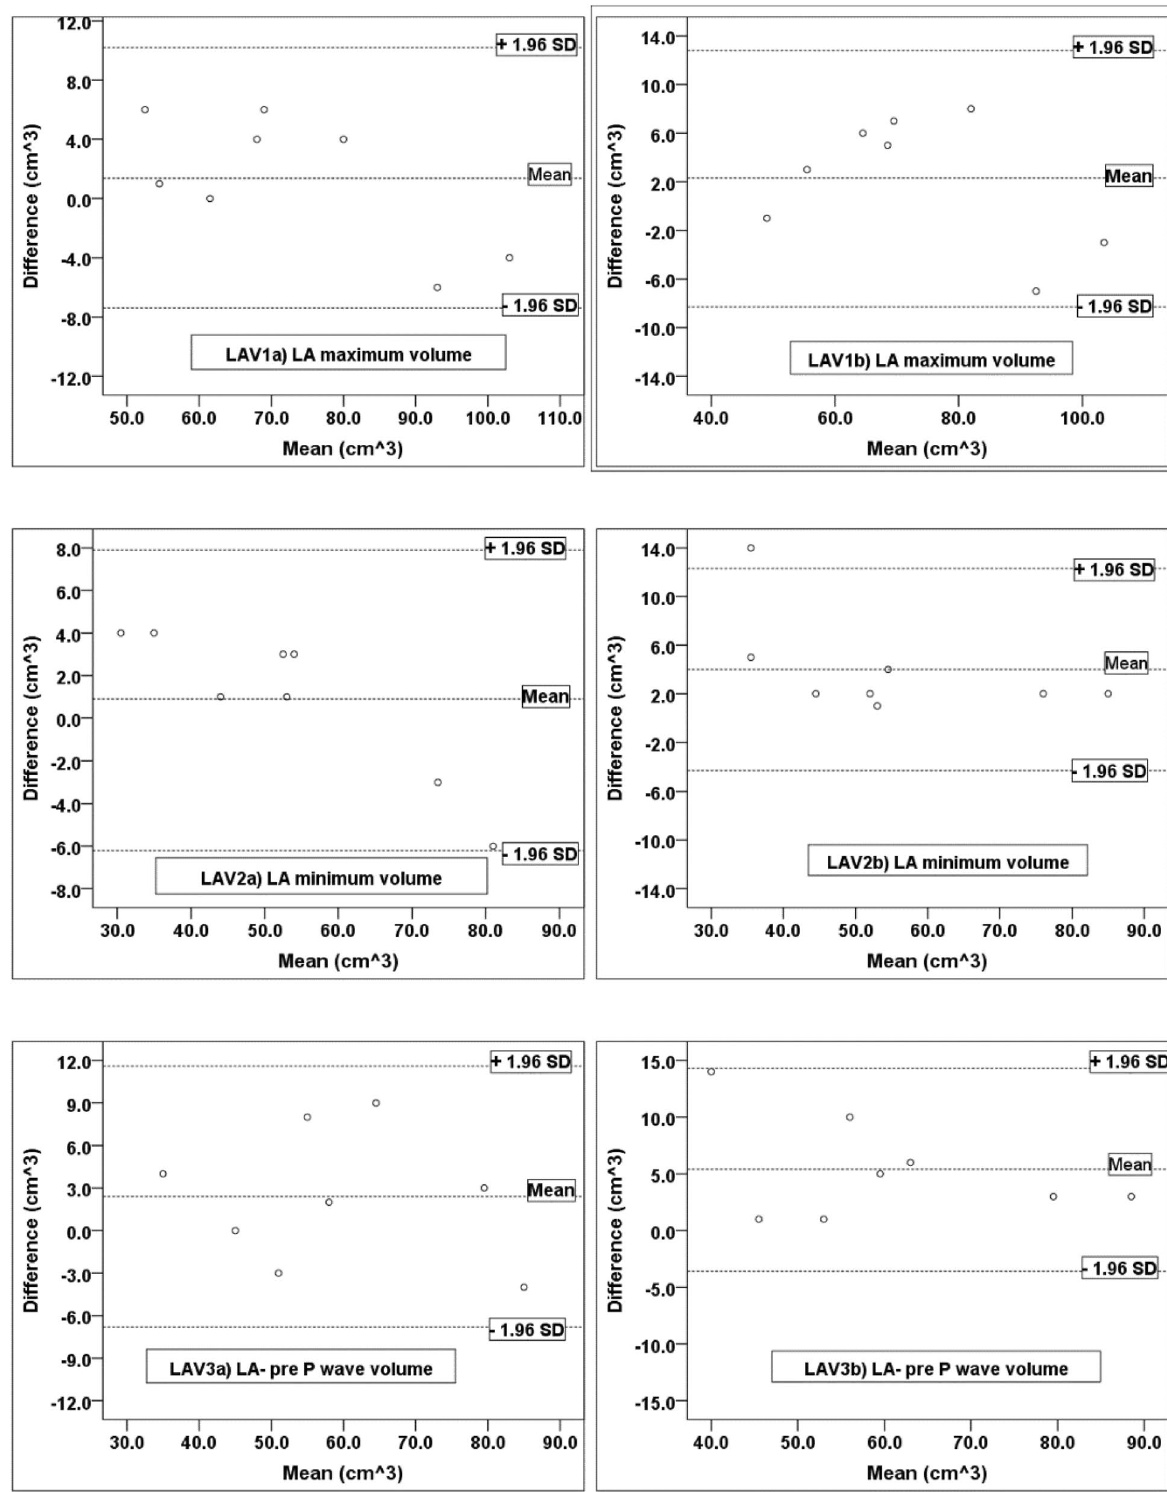
Fig. 5 Bland–Altman plots of intra-observer (LAV1a, LAV2a, LAV3a) cm 3 , and inter-observer (LAV1b, LAV2b, LAV3b) cm 3 , measurements of left atrial maximum volume, left atrial minimal volume and, left atrial pre-P wave volume respectively. Denoting high intra-observer and inter-observer agreements (cm^3 denotes cm 3